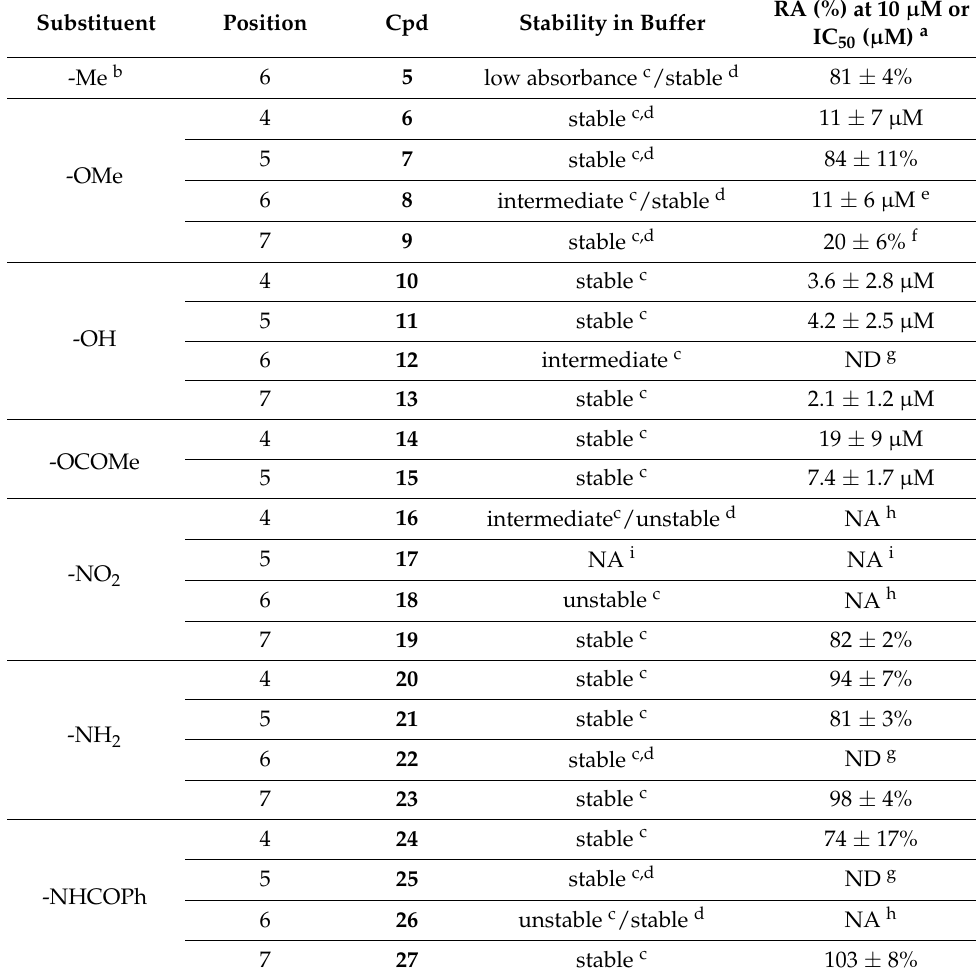
Table 2. Inhibitory potencies of benzoxazole-2-carbonitriles against the β 5i subunit of human iCP. The RA values were determined at 10 µ M of compounds and 30 min pre-incubation. PR-957